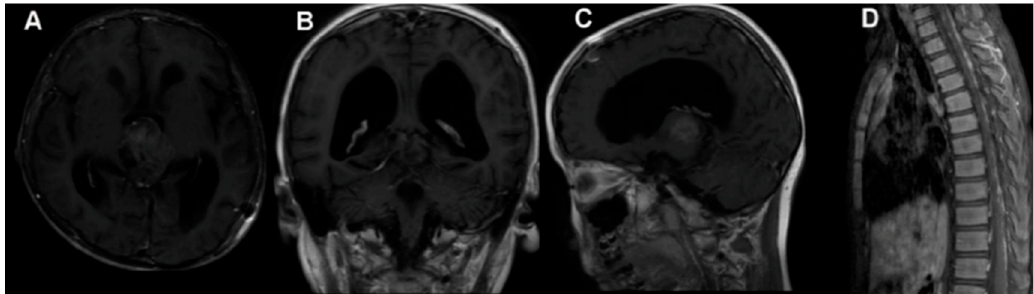
Figure 7. Pineoblastoma MRI. Preoperative MRI ( A – C ), MRI 1.5 months after surgery showing spinal metastasis ( D ). Reprinted with permission from Huo et al. (2020) [79]. Dove Medical Press—2021.